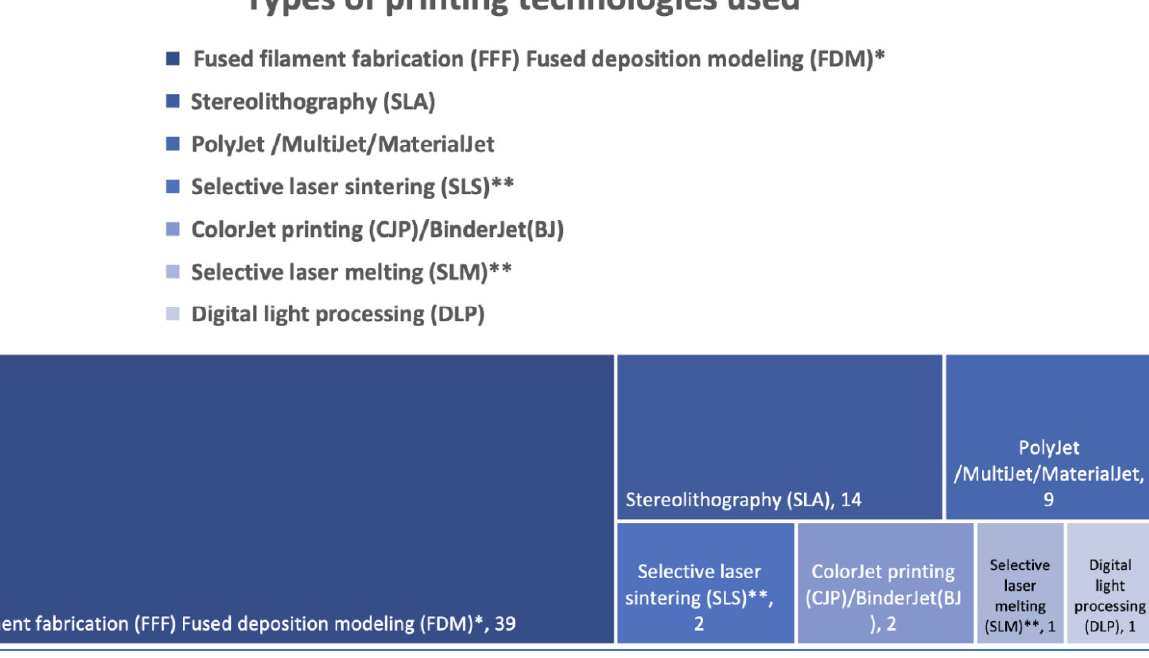
Figure 4. Printing technologies used across the studies (”*”—the same technology; ”**”—described as being part of an in-house process but not yet widely accessible for hospital use).